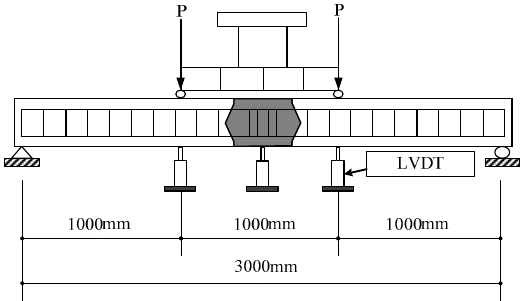
Figure 3. Experimental setup. LVDT: linear variable differential transformer.